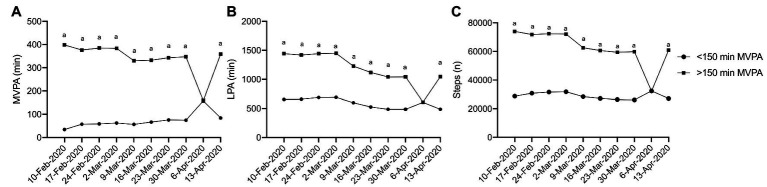
Physical activity during physical distancing week 1 activity level. (A) MVPA; (B) LPA; (C) Steps; (a) represents a significant difference between the two groups. For clarity, only selected significant differences are indicated on the figure.